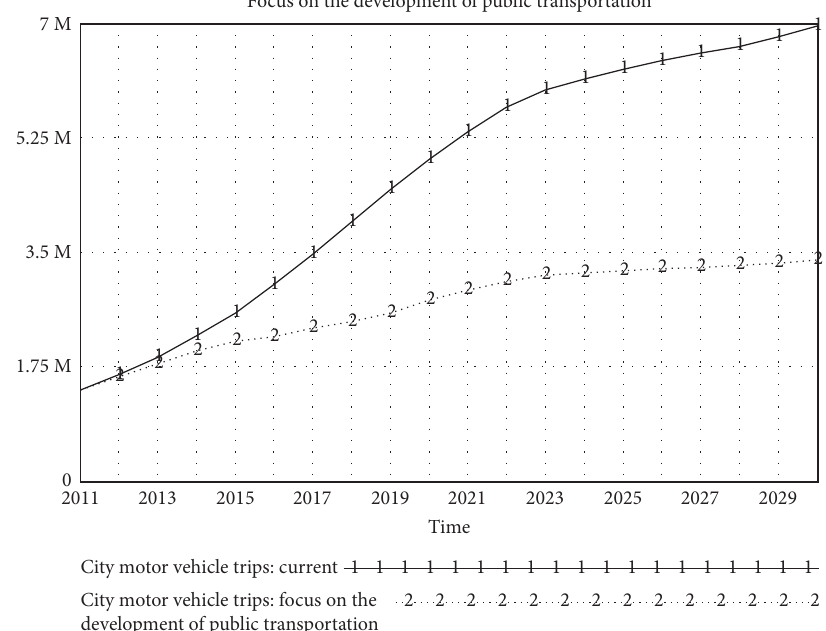
Figure 11: Focus on the development of public